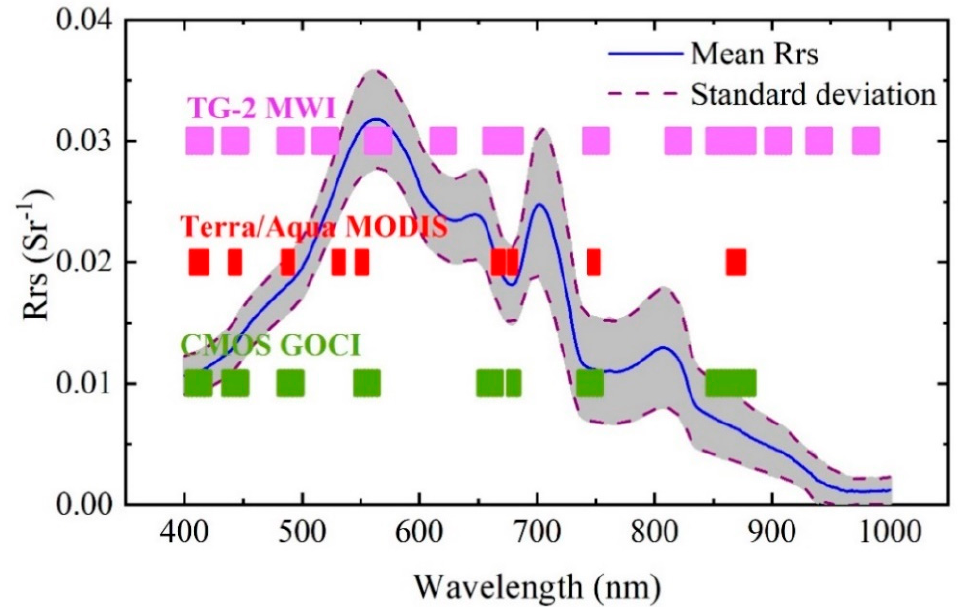
Figure 10 . The bands configuration of TG ‐ 2 MWI, Terra/Aqua MODIS and CMOS GOCI, overlaid Figure 10. The bands configuration of TG-2 MWI, Terra/Aqua MODIS and CMOS GOCI, overlaid with the mean and standard deviation of 𝑅 (cid:3045)(cid:3046) at Taihu Lake. with the mean and standard deviation of R rs at Taihu